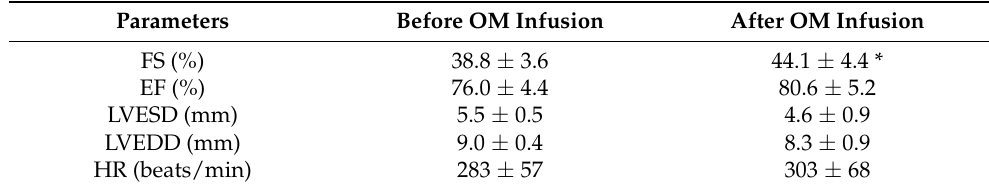
Table 2. Echocardiographic measurements in rats (n = 6) at baseline and 30 min after OM infusion.